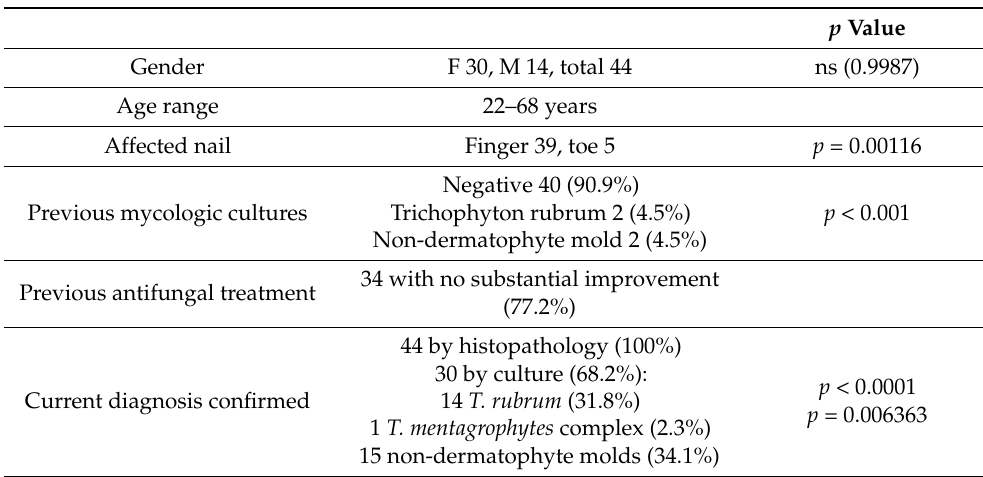
Table 1. Demographic